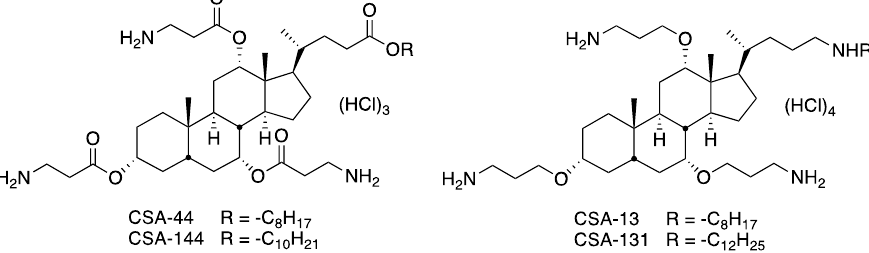
Figure 1. Structures of ceragenins CSA-44, CSA-144, CSA-13 and CSA-131.